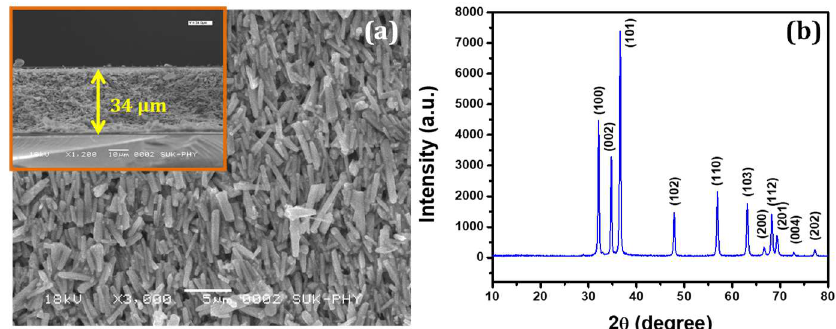
Figure 3. Morphological and structural characterization of the ZnO thin film. ( a ) Surface morphology of the ZnO thin film. The inset represents the cross-sectional SEM image of the ZnO thin film; ( b ) XRD patterns of ZnO powder sample.